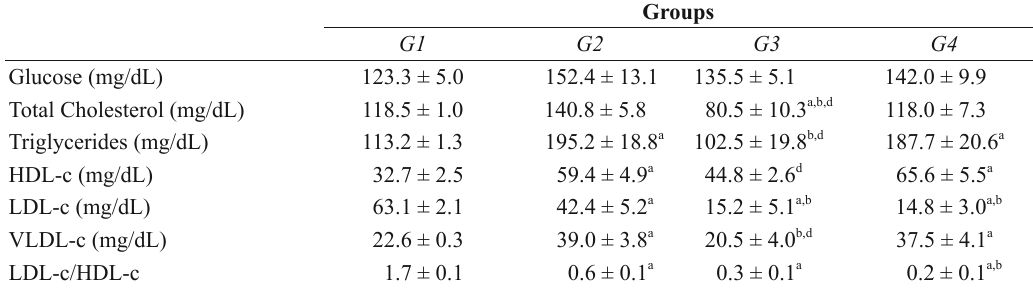
Data shown as mean ± standard error. G1 = Sedentary and Non-supplemented Group (Control Group), G2 = Sedentary and Supplemented Group, G3 = Physical Exercise and Non-supplemented Group, and G4 = Physical Exercise and Supplemented Group. ANOVA followed by Holm-Sidak test. a p<0.05 compared to G1 group. b p<0.05 compared to G2 group. c p<0.05 compared to G3 group. d p<0.05 compared to G4 group.